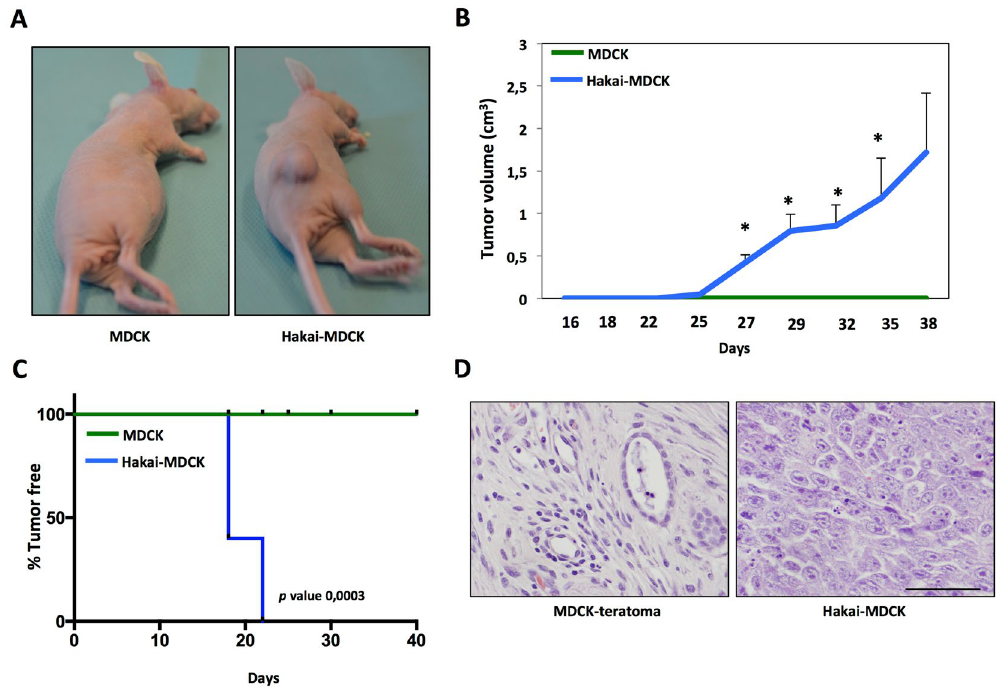
Figure 2. Hakai induces tumour formation in vivo . (A) Representative photographs after 38 days of subcutaneous injection of 5 × 10 6 MDCK or Hakai-MDCK into nude mice cells (MDCK, n = 4; Hakai-MDCK, n = 5). (B) Tumour growth in nude mice injected with MDCK or Hakai-MDCK. Tumours were measured twice a week, as described in Materials and Methods and results are represented as mean ± SEM ( * P < 0,05). (C) Tumour-free survival of MDCK or Hakai-MDCK cells in nude mice. p value was calculated with Breslow test and is indicated in the figure. (D) Representative H&E staining of teratoma and tumours originated by MDCK or Hakai-MDCK cells, respectively. Pictures were taken with a 40x objective, scale bar 500 μ